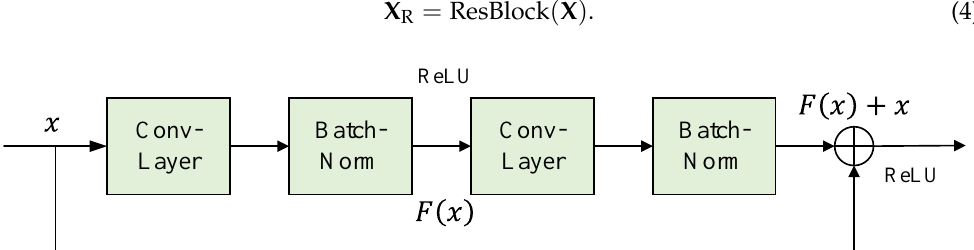
Figure 3. Illustration of residual